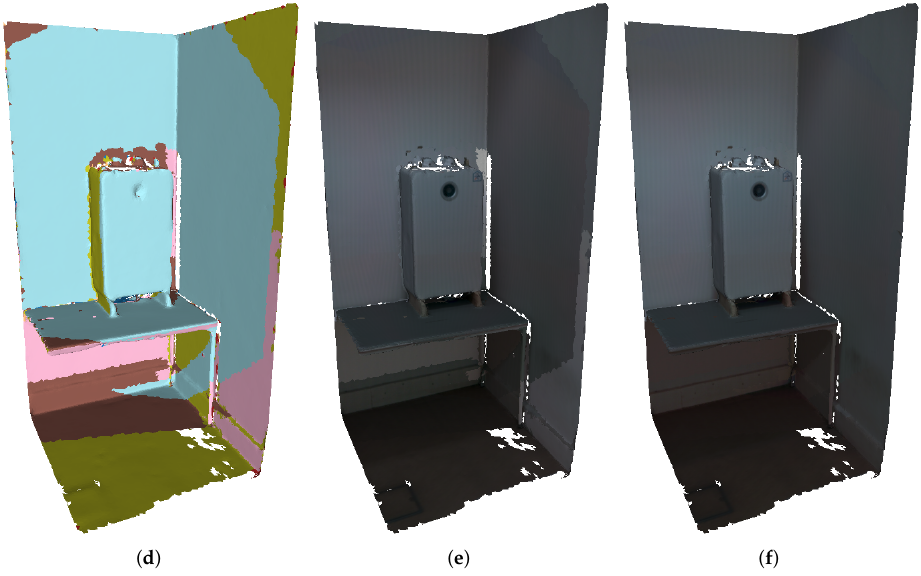
Figure 9. Textured meshes produced. ( a , d ) illustrate the result of the random selection and the selection based on the largest area of the projection, respectively. The color of each face is associated with the selected image, meaning that faces with the same color have the same selected image. The resultant textured mesh with random selection as the image selection technique is depicted in ( b ) using the original images, and in ( c ) using the color corrected images. The resultant textured mesh with image selection based on the largest area of the projection is depicted in ( e ) using the original images, and in ( f ) using the color corrected